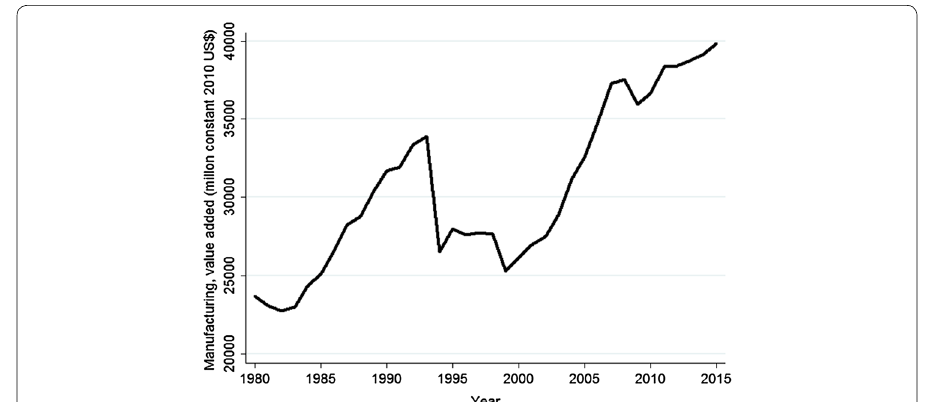
Fig. 2 Colombia: manufacturing output. Source : Author’s calculations based on World Bank